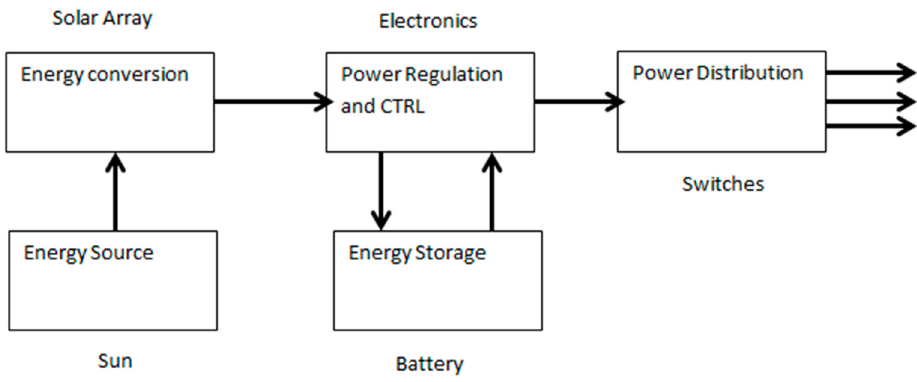
Figure 6. Simplistic Overview of a CubeSat Power Sub-System [27].